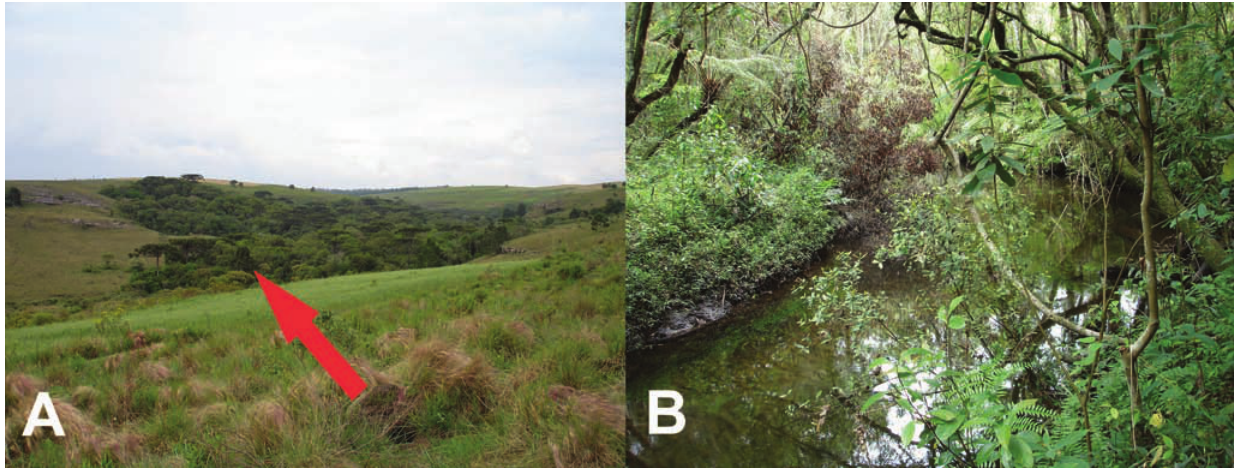
Fig. 4. Type locality of Astyanax eremus , new species, Amola Faca/Registro Farm, Balsa Nova, Paraná (A: panoramic view of the type locality; B: sample site). Red arrow indicates the sample